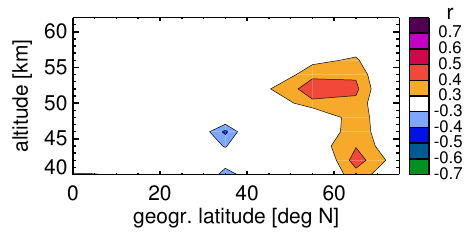
Fig. 4. Correlation coefficient r of the SEA with respect to ∆ Ap (epoch type 2) between ∆ Ap and ∆NO 2 with a delay of one day, plotted over geographic latitudes.